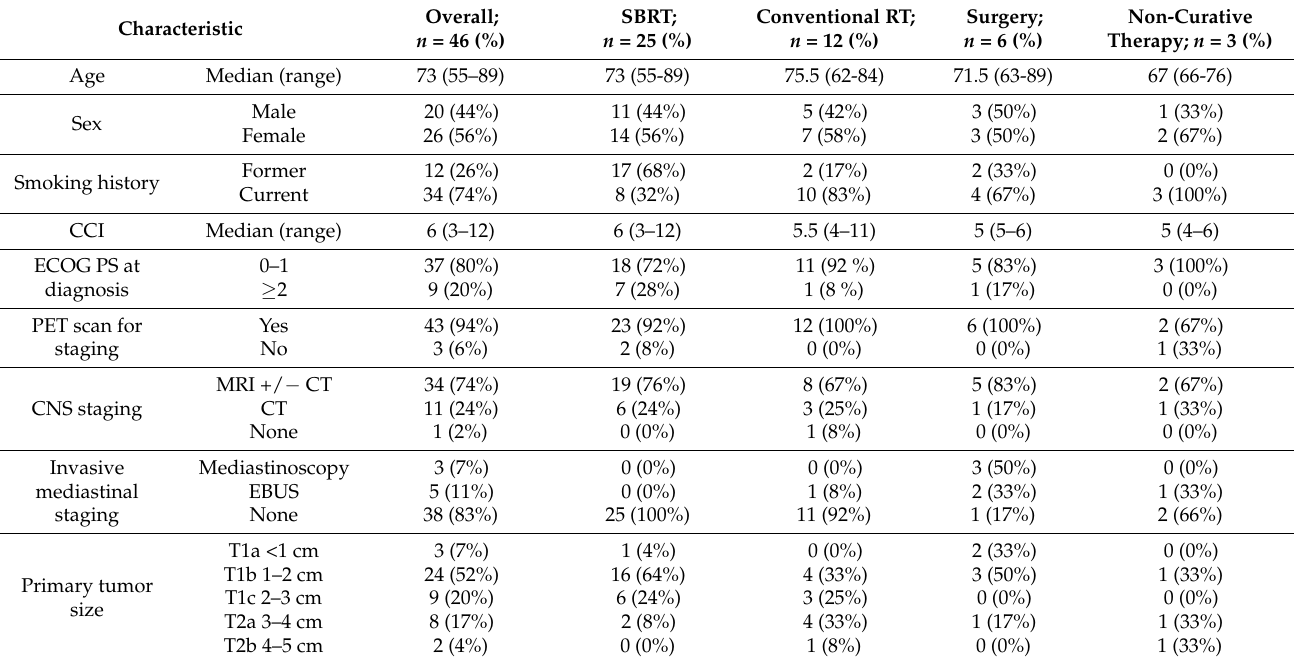
Table 1. Baseline characteristics of study